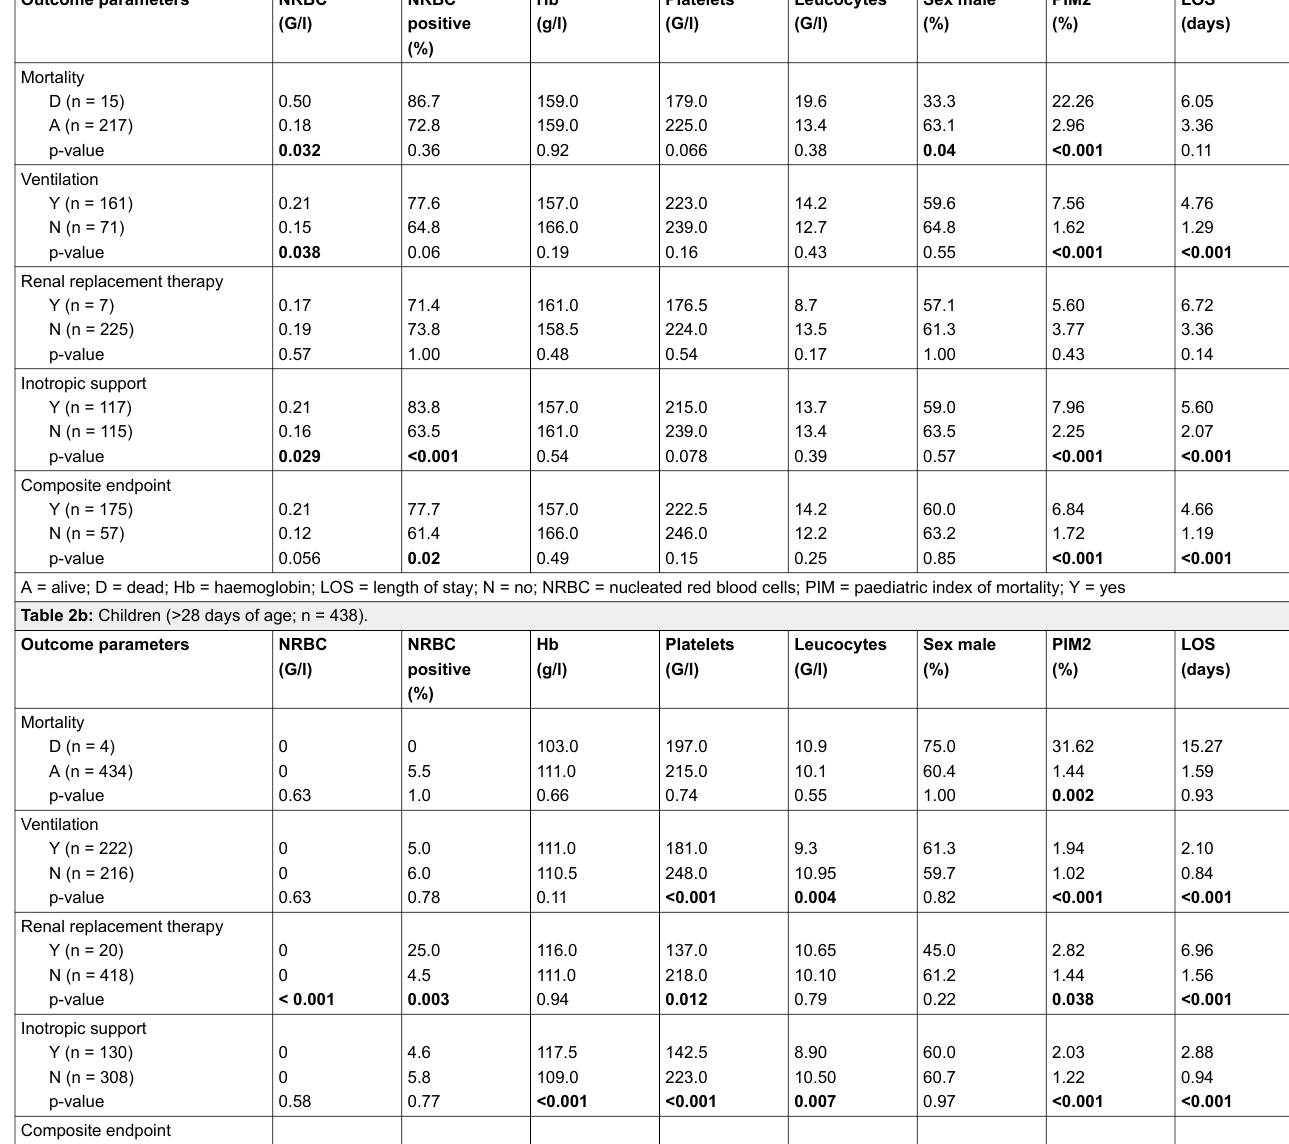
Table 2: Univariate analysis based upon clinically important outcomes compared with demographic and haematological variables as well as severity of illness parameters. For nominal variables, relative frequencies are shown; for continuous variables, median is displayed. Composite endpoint: death and/or ventilation and/or renal replacement therapy and/or inotropic support. All p-values <0.05 are in bold type. Table 2a: Neonates (≤28 days of age; n = 232). Outcome parameters